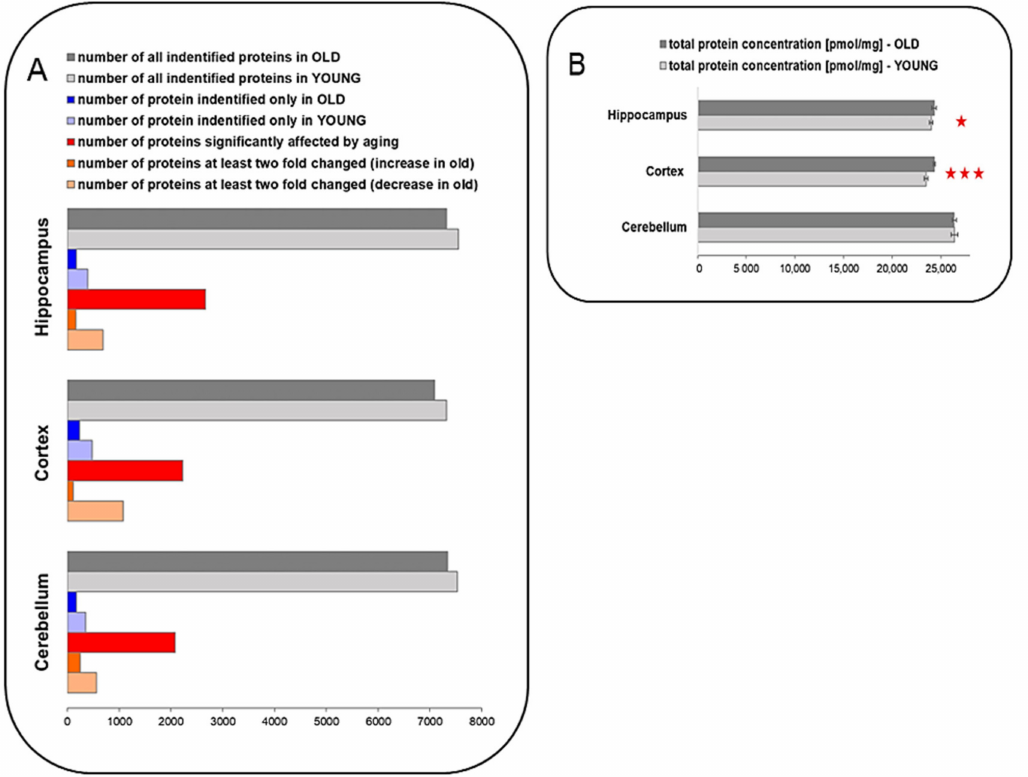
Figure 2. The effect of aging on protein expression in brain structures. ( A ) The comparison of the number of proteins identified in the hippocampus, cortex, and cerebellum. Some of the proteins are unique only for old or young animals. Moreover, approximately 36%, 31%, and 28% of proteins are significantly altered by aging in the hippocampus, cortex, and cerebellum, respectively. We found that 11–16% of the total identified proteins changed at least twofold in old animals. ( B ) Total protein concentration increases significantly in the hippocampus and cortex (* p < 0.05 and *** p < 0.001, respectively) of the old animals, compared to the young ones. Abbreviations: YOUNG—1-month-old, OLD—22-month-old